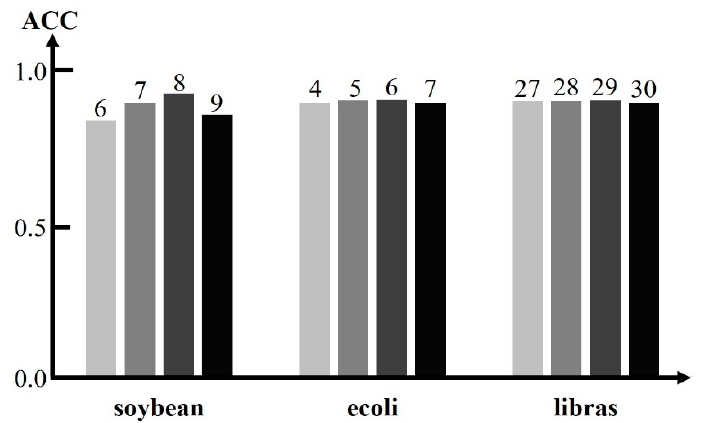
Figure 8. Performance of SL-Scheme with variation in the number of hidden neurons.